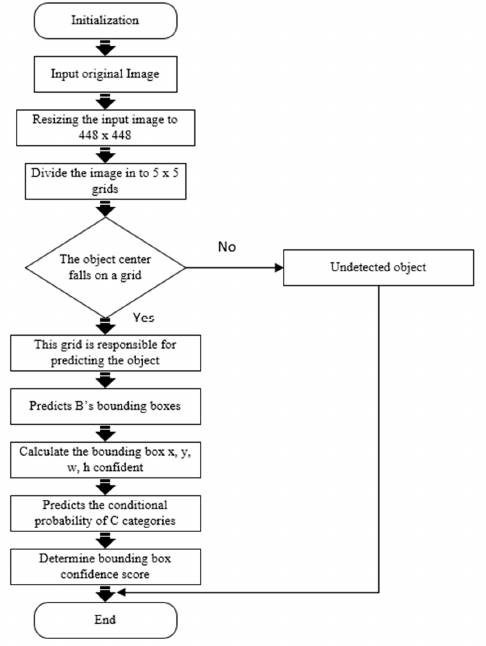
Figure 2. YOLOv2 detection flowchart .